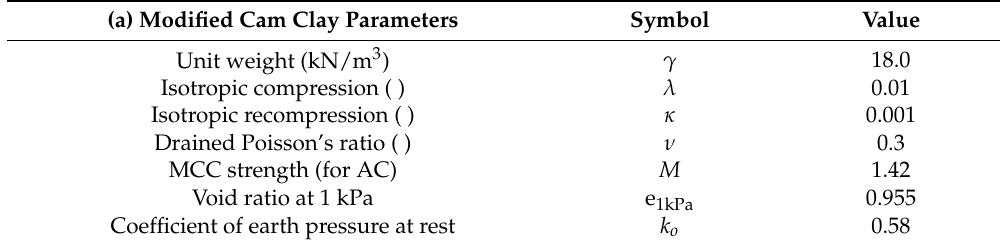
Table 1. Model parameters used in this study. Initial k o values are obtained from other parameters of Modified Cam clay model. AC indicate axial compression in triaxial condition.